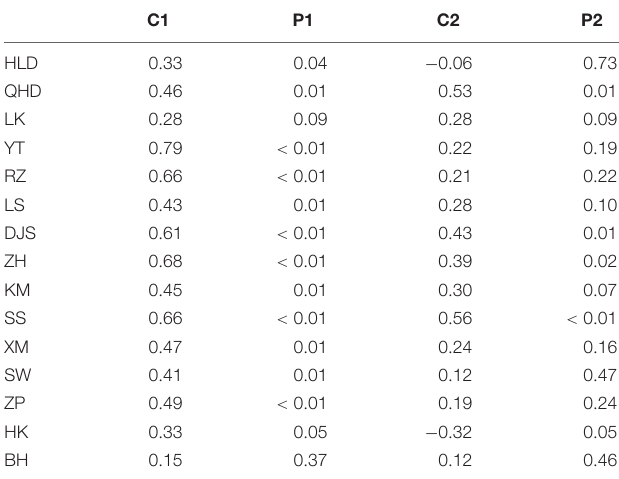
TABLE 2 | Correlation coefficient between the extreme sea level and mean sea level at 15 tide gauges (C1) and the correlations after detrending (C2), the P1/P2 are the p -value from t -test (where p < 0.05 means that the correlation was significant at 95% confidence level).